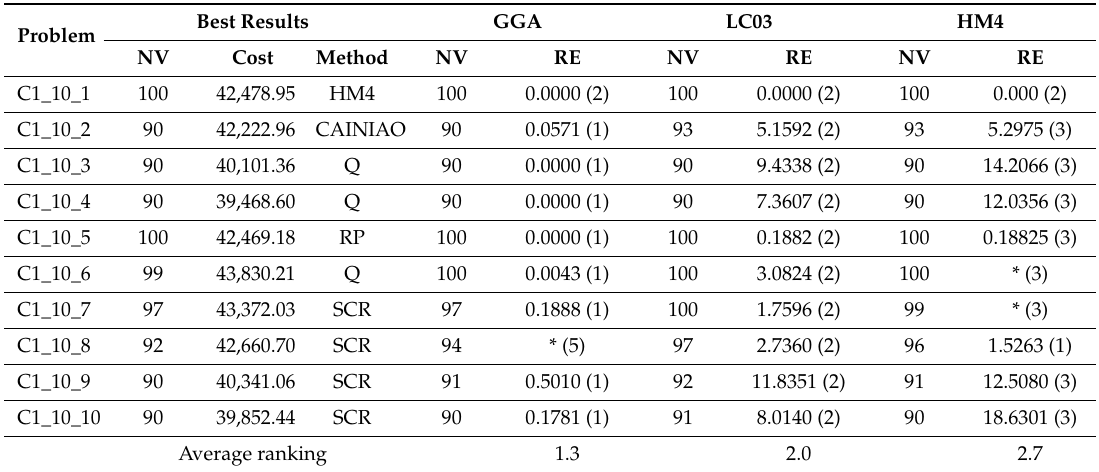
Table 7. Comparison of the experimental results with 10 Gehring and Homberger benchmark